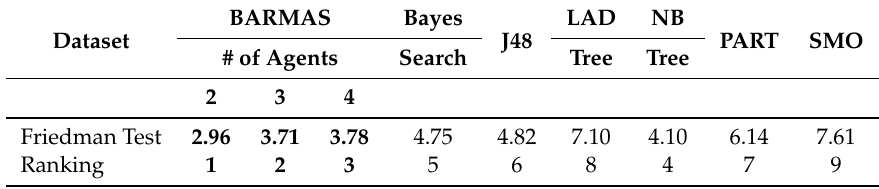
Table 6. Friedman test scores with average uncertainty levels. Best results are marked in